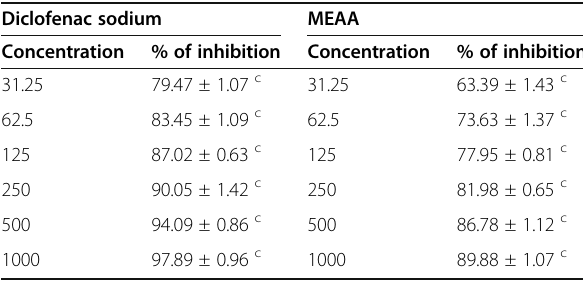
Values are expressed as mean ± SEM ( n = 3); c p < 0.001 are statistically significant comparison with diclofenac sodium followed by Dunnett ’ s